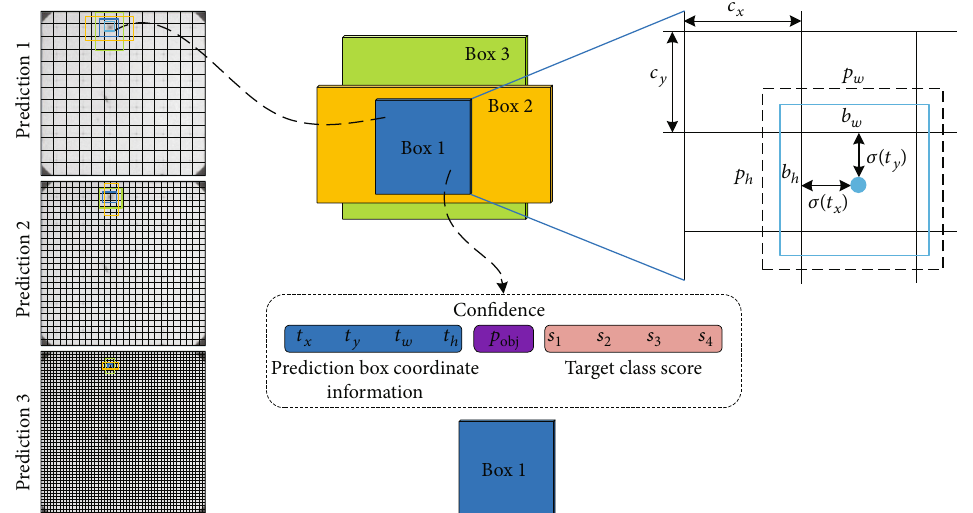
Figure 11: Schematic diagram of the spatial structure of the prediction layer.